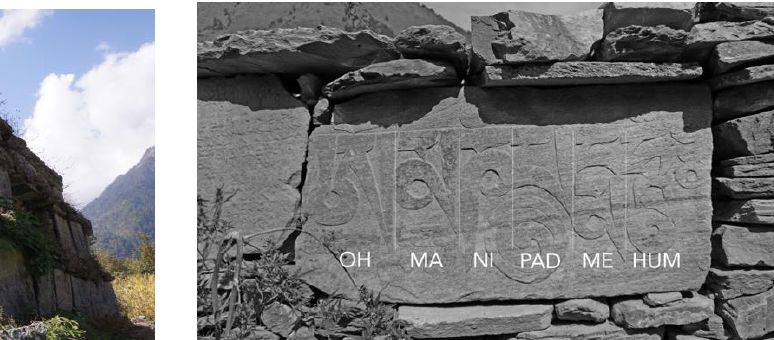
Figure 14. Chorten in Gatlang (Authors).